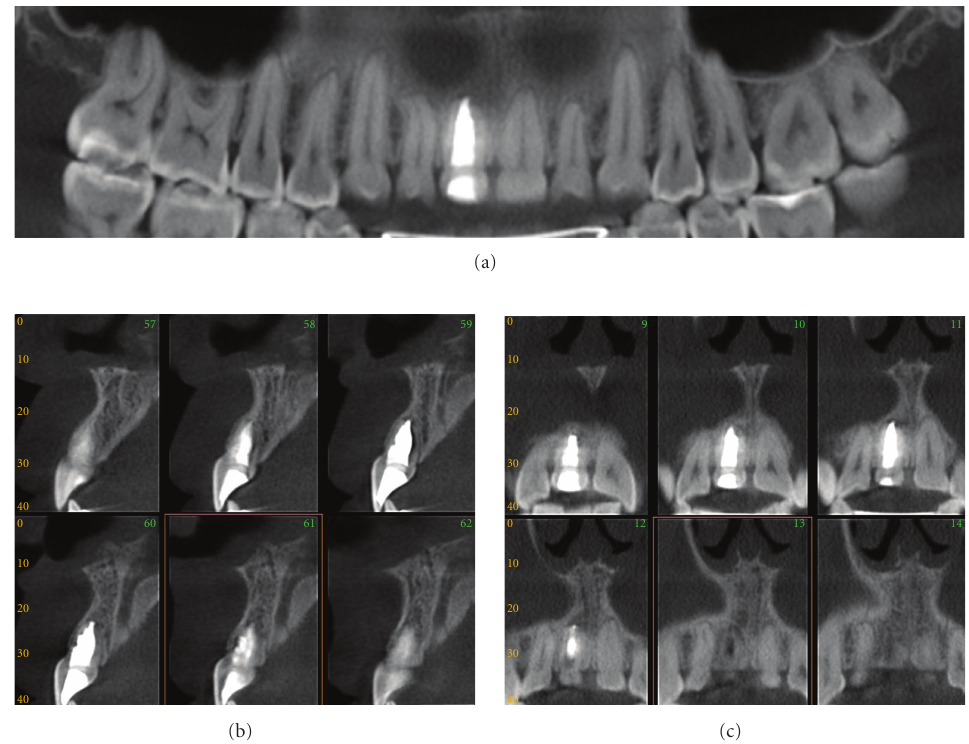
Figure 15: Replacement external resorption associated with root canal filled right maxillary central incisor. An oblique multiplanar reformatted “panoramic” image (a) shows the dentition with minimal restorations and a single root canal filled maxillary right central incisor; note that the obturation is large in relation to the width of the adjacent left maxillary central suggesting endodontic treatment at an early age. Sequential 1mm cross-sectional (b) and parasagittal (c) images show bone trabecular-like replacement of the superior and palatal aspects of the root indicative of replacement resorption. Initial management consisted of conventional endodontic treatment. Because of the questionable long-term prognosis of the apical resorptive lesions, periodic CBCT imaging is recommended with a view towards surgical revision therapy consisting of apicoectomy and retrograde root canal treatment (data acquired on an iCAT, Imaging Sciences International, Hatfield, PA USA at 0.4 mm resolution and reformatted using InVivo Dental, Anatomage, San Jose,